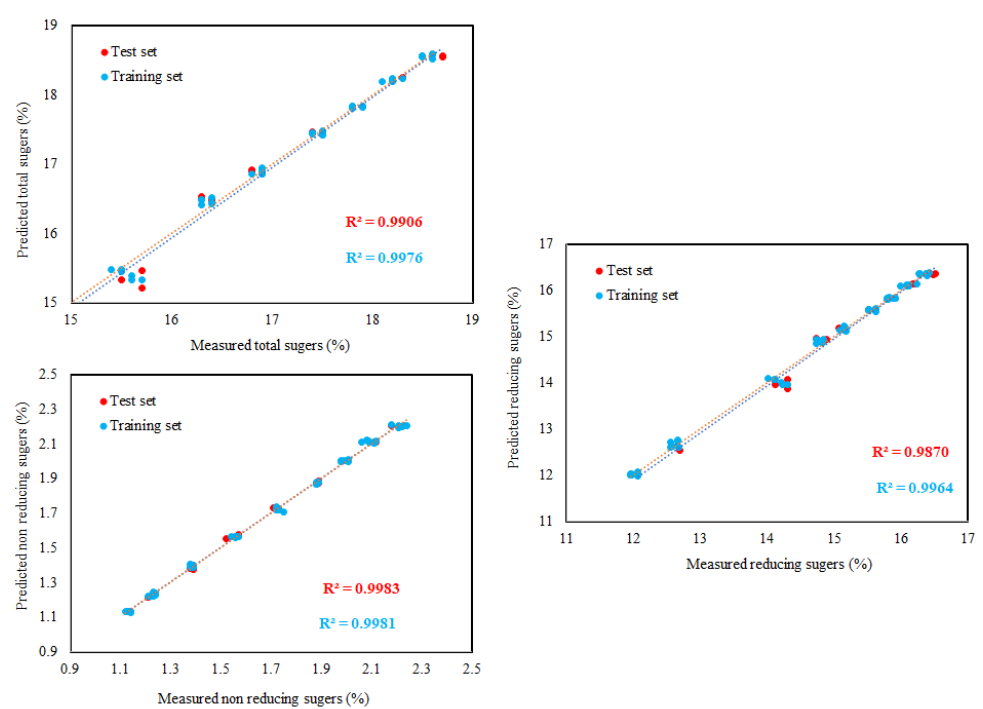
Figure 5. Predicted vs. experimental values of the TSS, titratable acidity TSS/acidity, and anthocya- nin using the optimal ANN topology and training and testing sets. The coefficients of determination (R 2 ) are reported.